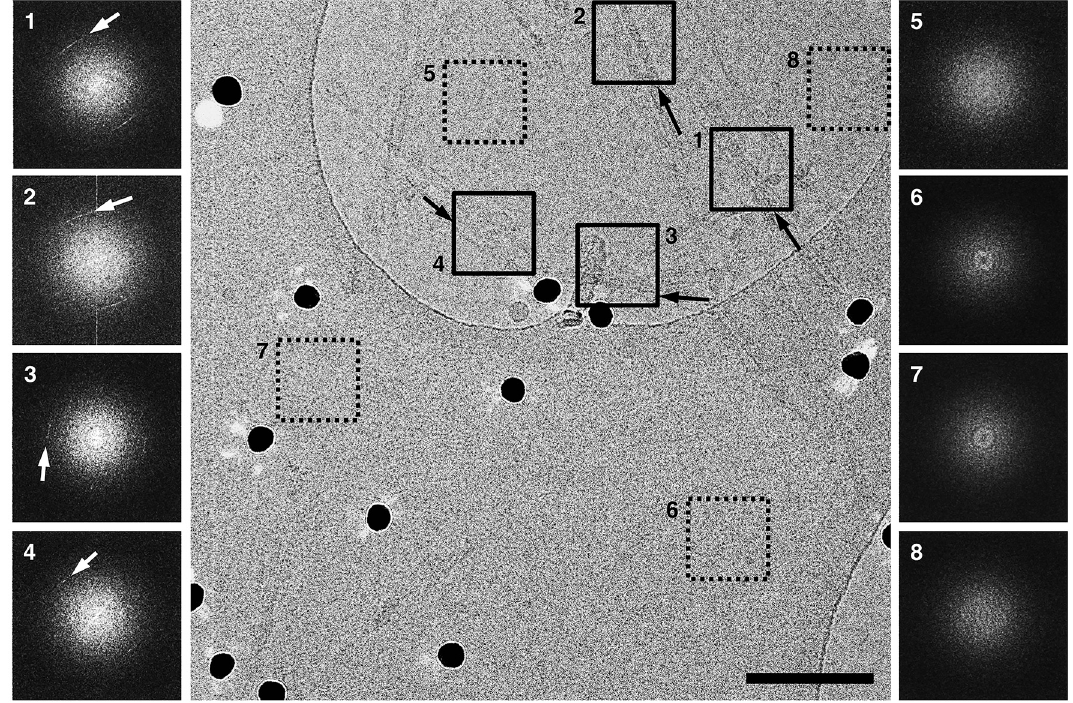
Fig 3. Raw cryo-EM images of GPI-anchorless prion fibrils show their basic features and 4.8 Å cross- β signals. A high-resolution cryo-EM image showing individual GPI-anchorless PrP 27 – 30 fibrils or small bundles of fibrils (solid boxes). Fourier-transform (FT) analyses from the corresponding boxes show 4.8 Å cross-ß signals that originate from the ß-strand stacking along the fibril axis and which follow the orientation of the fibrils (black and white arrows). FT analyses of areas of ice or carbon film, that were devoid of amyloid fibrils (dotted boxes), and which did not show any noticeable signals at 4.8 Å . Scale bar, 100 nm.